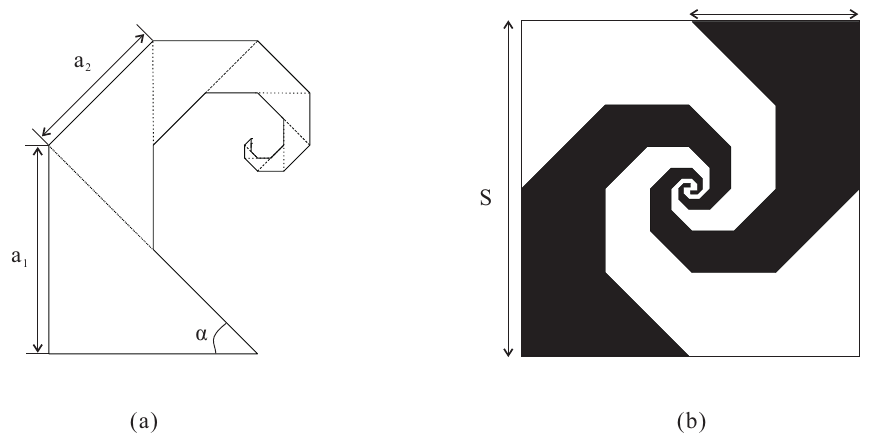
Figure 1. Geometry of ( a ) the Spidron fractal; ( b ) the self-complementary structure with the Spidron